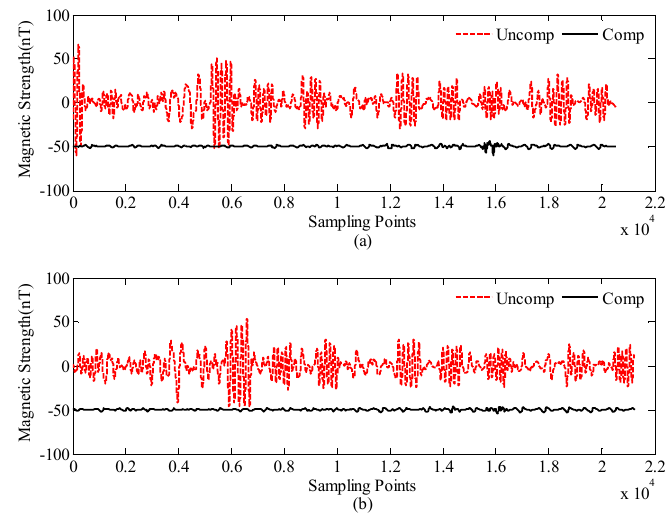
Figure 6. Compensation results of OPM-II: ( a ) calibration flight data and ( b ) test flight data.